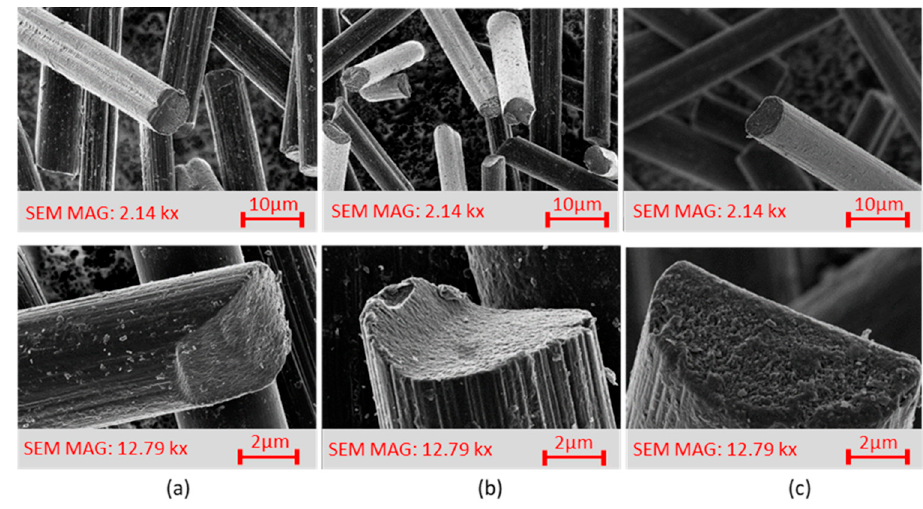
Figure 5. SEM photos of RCF (longitudinal views in the upper part of the figure, cross-sectional details in the lower part of the figure): ( a ) RCF; ( b ) MW plasma-treated for 1 min; and ( c ) RF plasma-treated for 30 s.